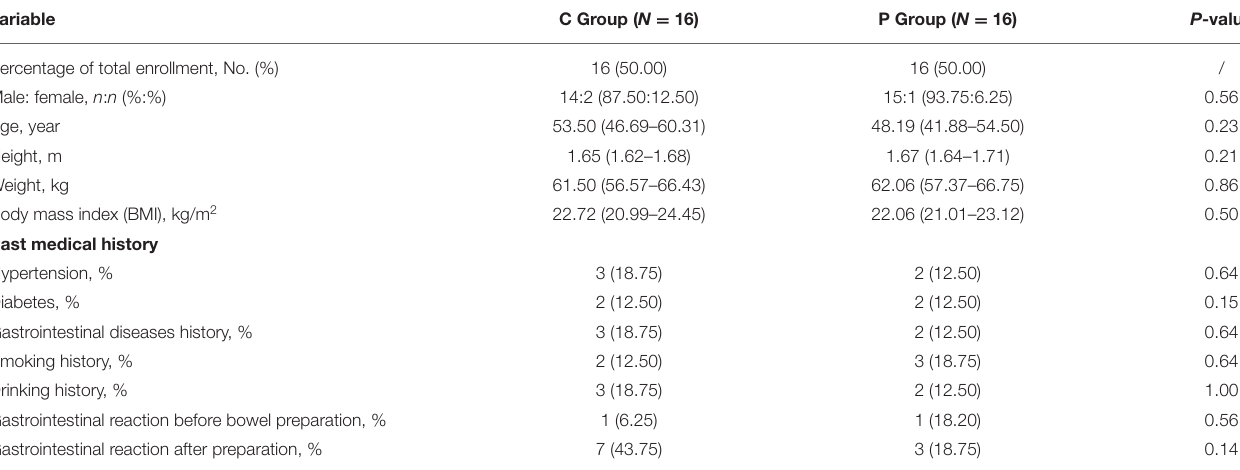
TABLE 1 | Baseline patient demographics and characteristics.